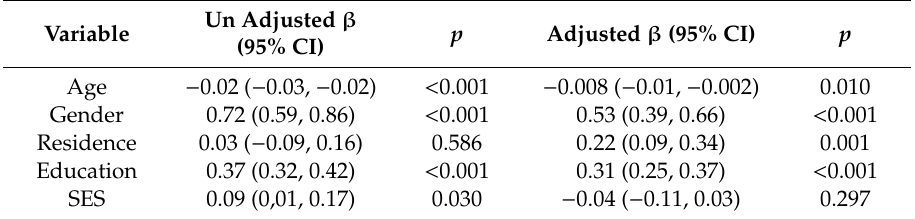
Table 4. Demographic association with the total knowledge score by Rasch analysis.